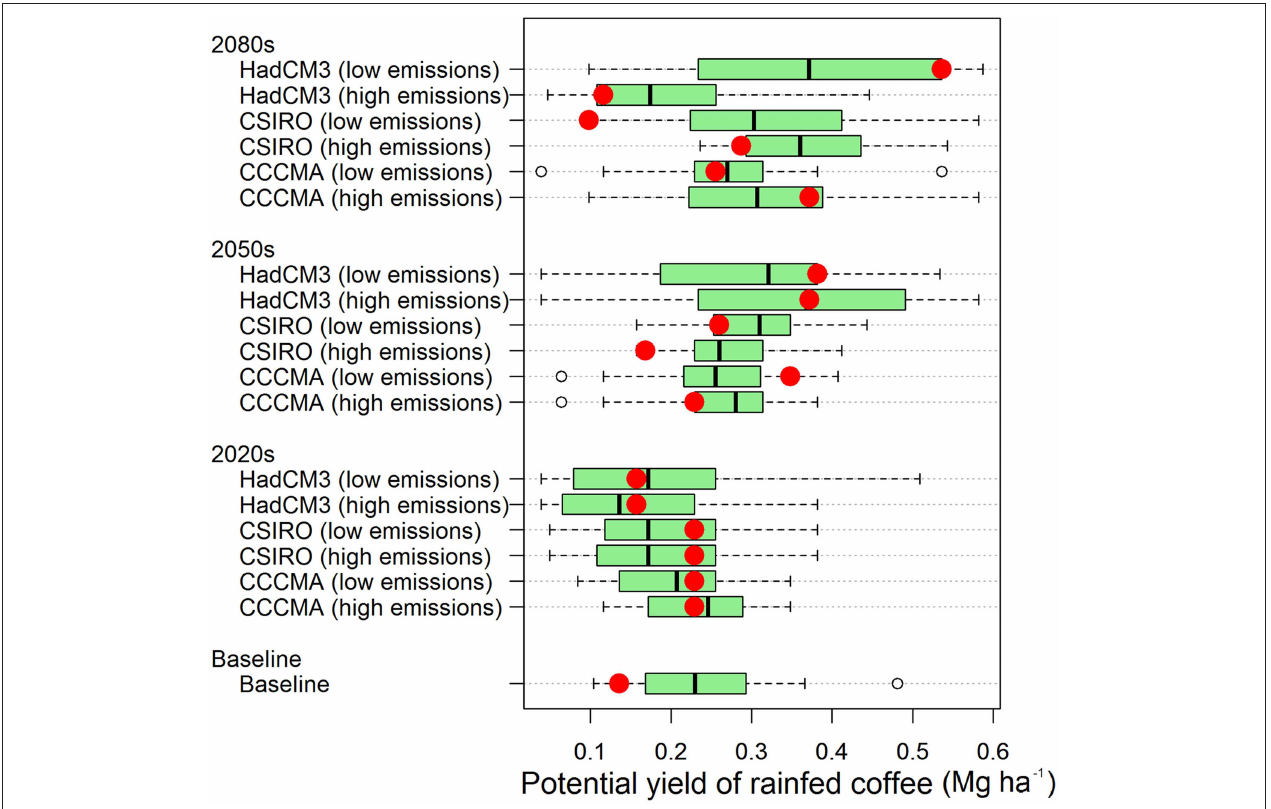
FIGURE 8 | Distributions of coffee yield potentials among 50 candidate climate analog locations of the baseline site on Mt. Elgon, Kenya, for each of 18 future climate scenarios. The 50 sampled sites are those grid cells where the current climate was most similar to the projected future climate at the baseline location, for the respective climate scenario. Low emissions refers to the B2a and high emissions to the A2a greenhouse gas emissions pathway. Red dots mark the closest